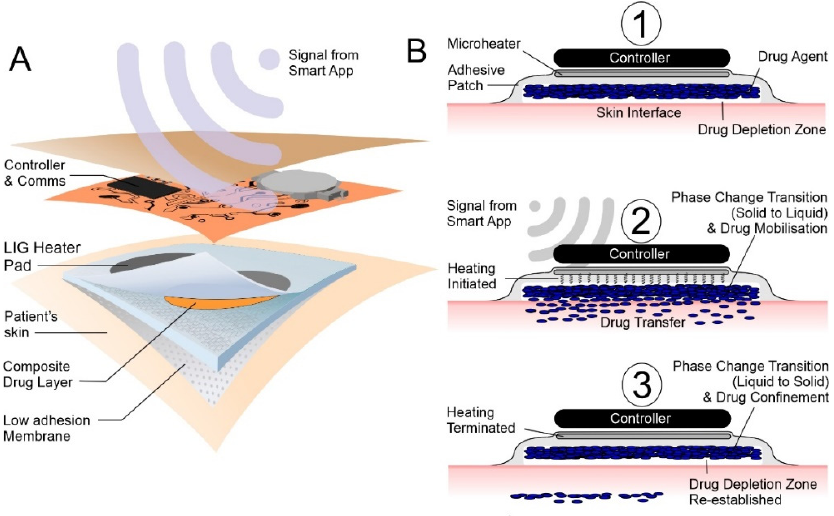
Figure 1. ( A ) Before activation, the drug is immobile and not in contact with the skin. ( B ) Activation initiates the heating cycle (1) facilitating phase change and mobilisation of the drug to the skin interface (2). Terminating the heating cycle (3), the system cools, phase change reoccurs, and the drug is once more rendered immobile.